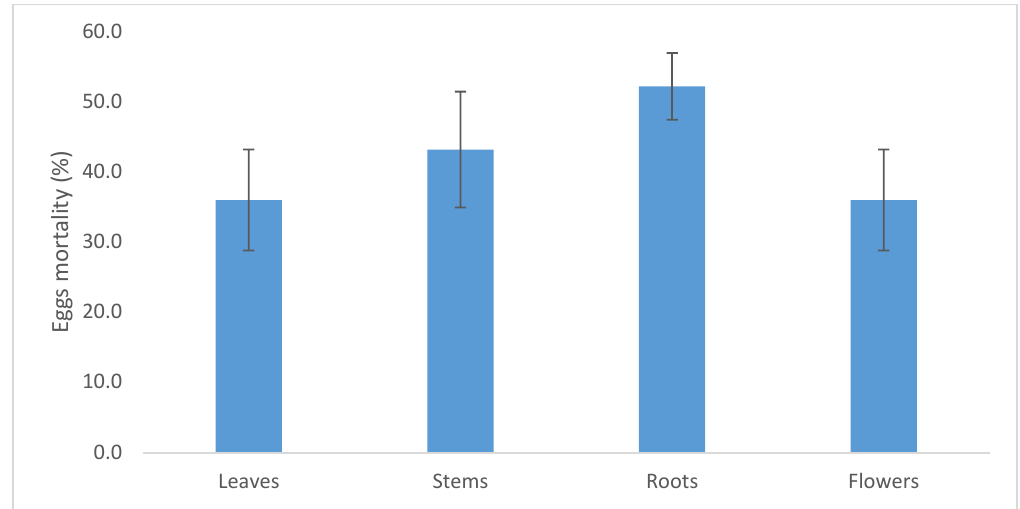
Figure 4. Cadra cautella eggs mortality when treated with the C. procera latex extracts. Bars represent standard error.